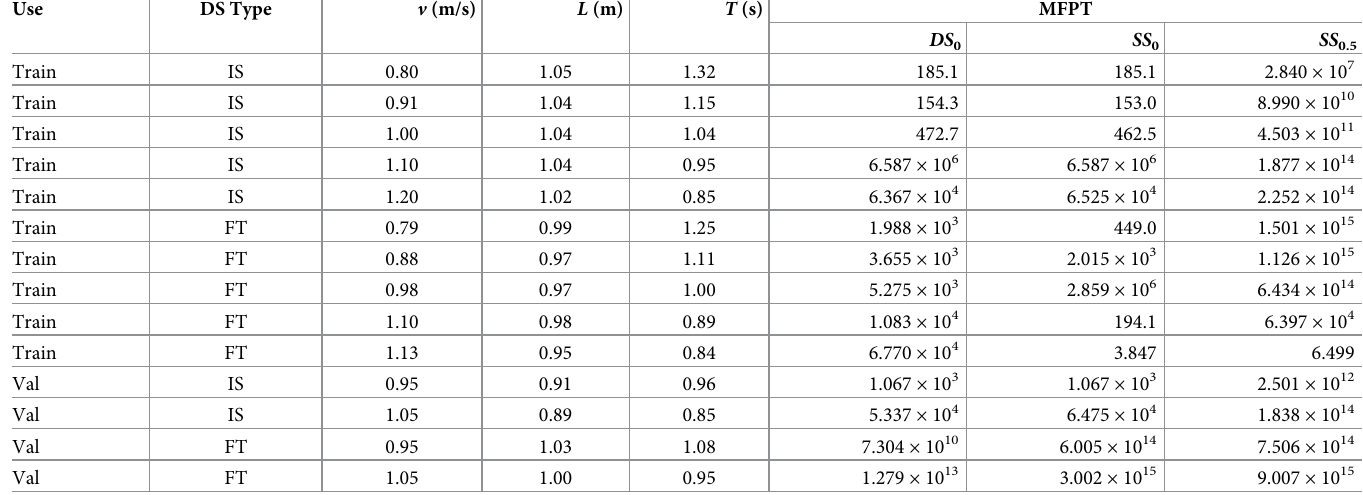
Table 1. Details for gaits used in this paper. The first column indicates if the gait was used to develop the fall prediction model (“Train”) or validate it (“Val”). The second column indicates the double support type, either instantaneous (“IS”) or finite-time (“FT”). The next three columns give the speed, step length, and step duration for the periodic gait. The final three columns give the mean first passage time when the perturbations were applied at the beginning of double support (“ DS 0 ”), at the beginning of single support (“ SS 0 ”), or halfway through single support (“ SS 0.5